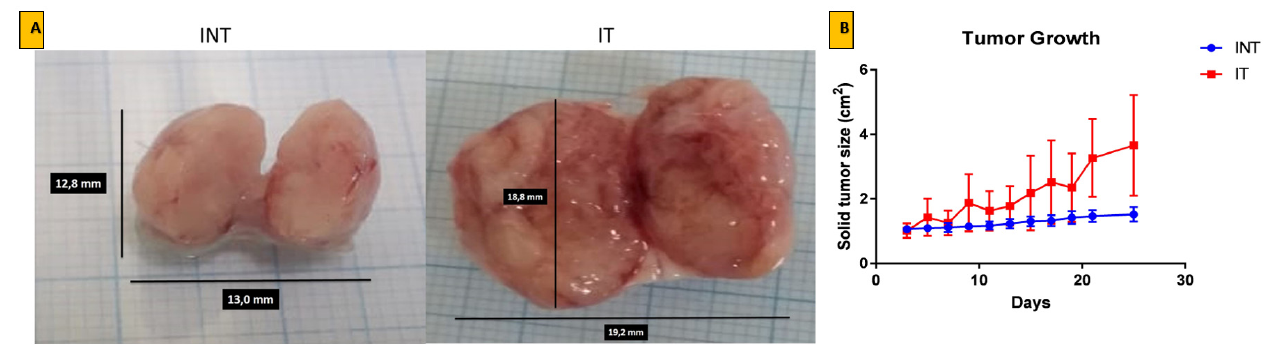
Figure 1. Growth of solid breast cancer mass after ECCT exposure treatment. ( A ) Representation of solid tumor mass after surgery and ( B ) the solid breast tumor growth curve based on the diameter of tumor nodules. Tumor growth measurements were taken every two days for 21 days. INT= DMBA-induced rats without EF therapy, IT= DMBA-induced rats with EF therapy